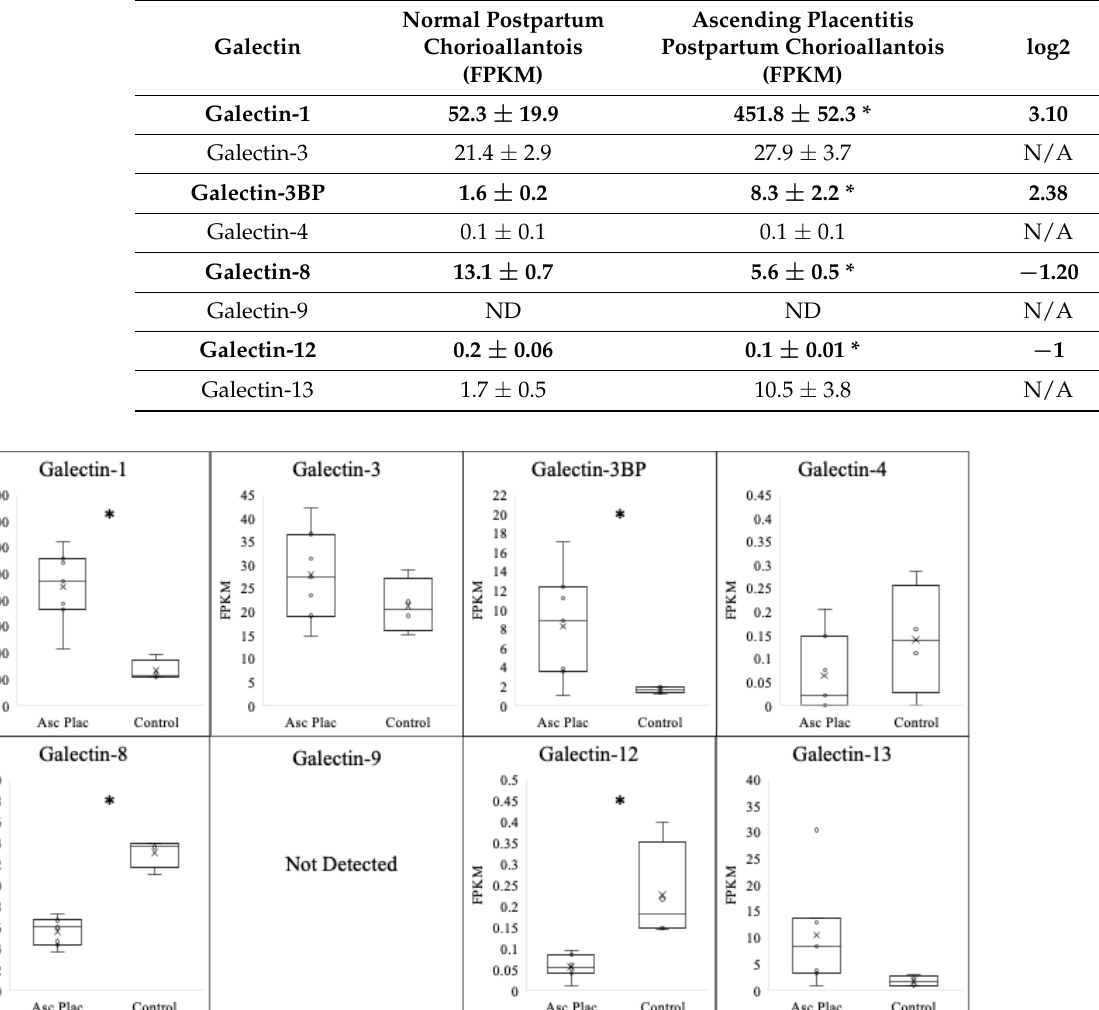
Table 1. Expression of various galectins following ascending placentitis. FPKM = fragments per kilobase measured. * p < 0.05, ND = no detectable expression.